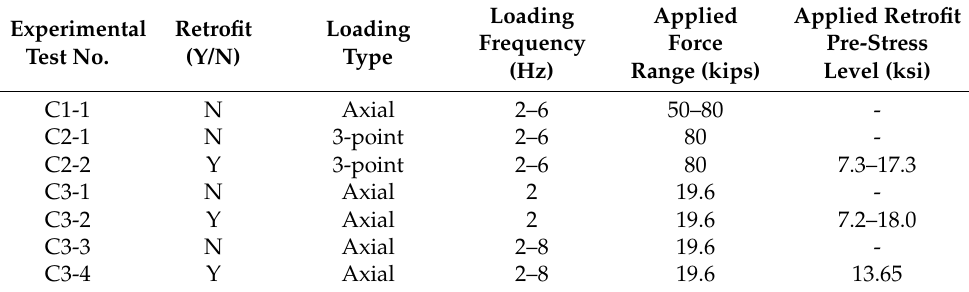
Table 7. Experimental test matrix.